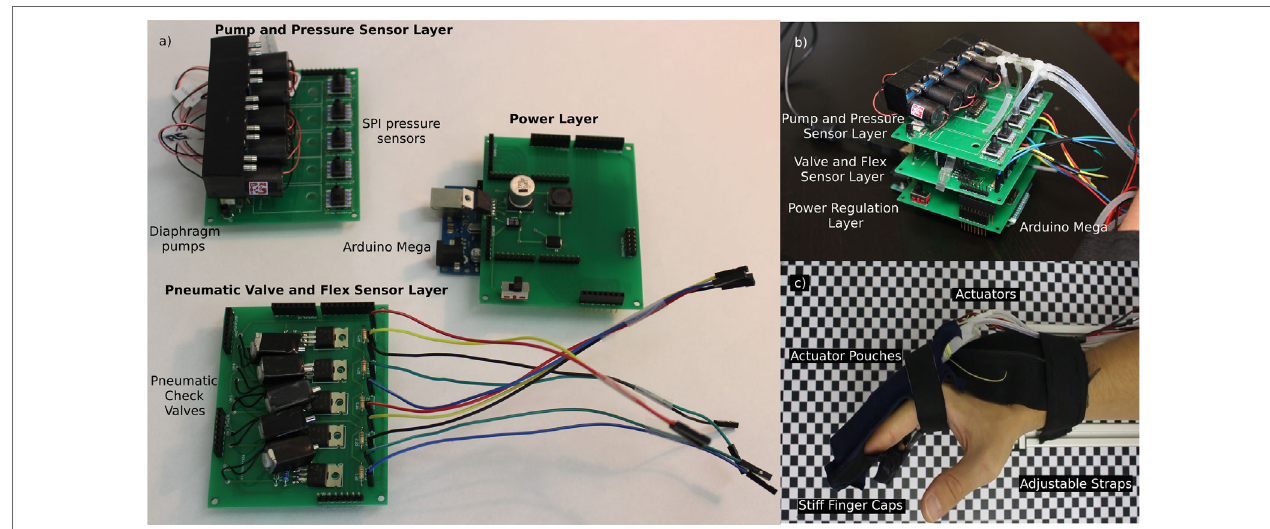
FigUre 2 | The electropneumatic controller for the soft Orthotic Physiotherapy hand interactive aid system consists of a modular series of components that connect via a tether to a soft robotic glove . This system is capable of extending a subject’s hand from a closed grasp to an open grasp. This figure shows: (a) the three layers in the electropneumatic control system; (B) the assembled, modular, electropneumatic control system; and (c) the pneunet-based soft exoskeletal glove system mounted on a subject’s